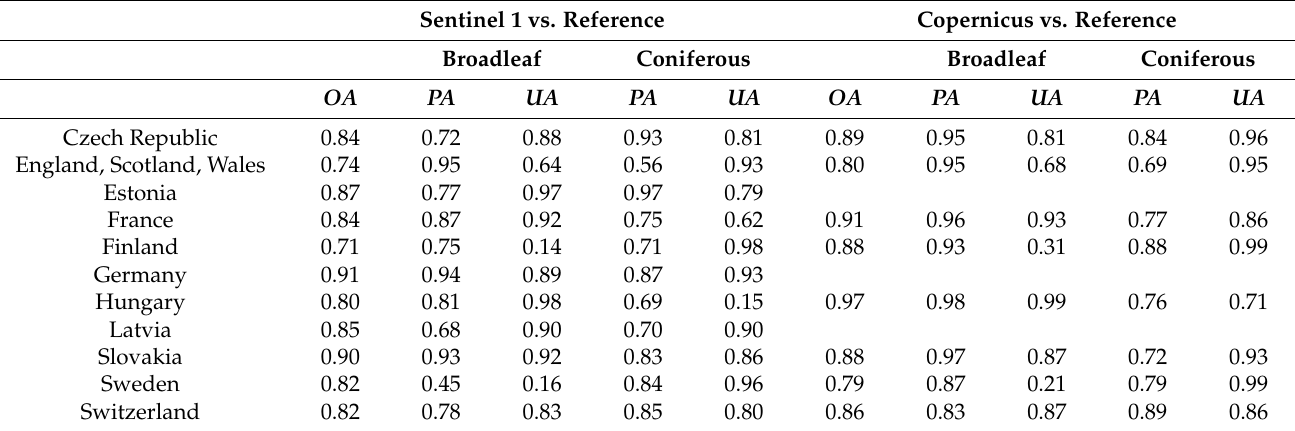
Table 4. Results of the accuracy assessment using the national datasets for the forest type classification. The following statistics are listed: overall accuracy ( OA ), producers’ accuracy ( PA ) and users’ accuracy ( UA